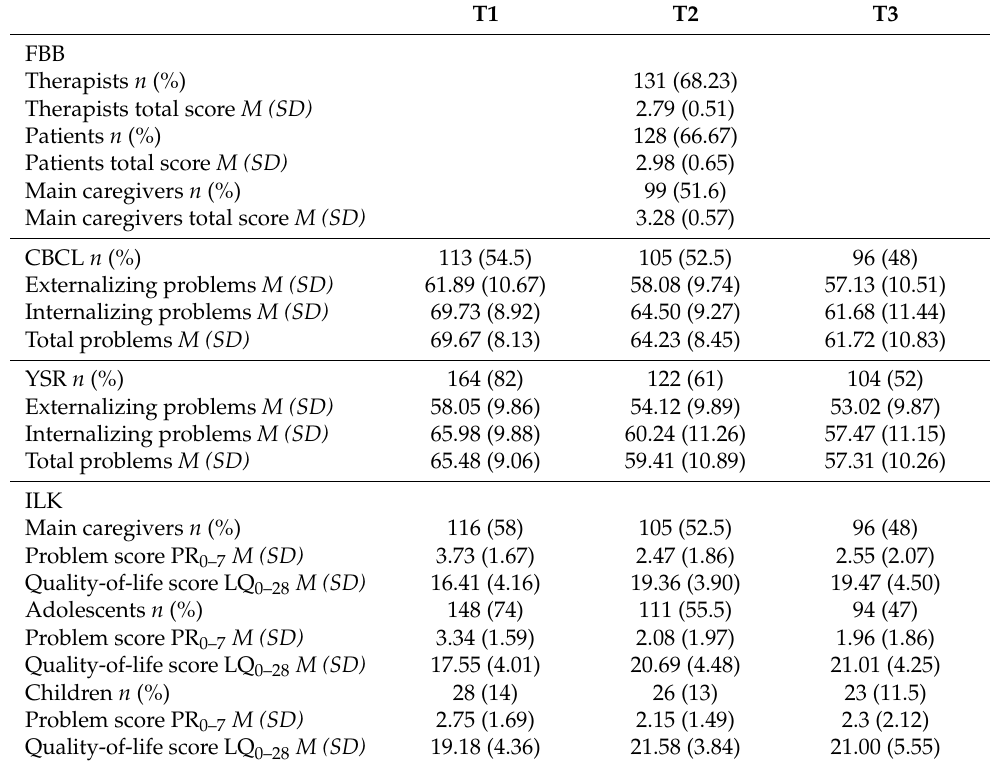
Table 1. Overview of sample sizes, means, and SD for all scales and